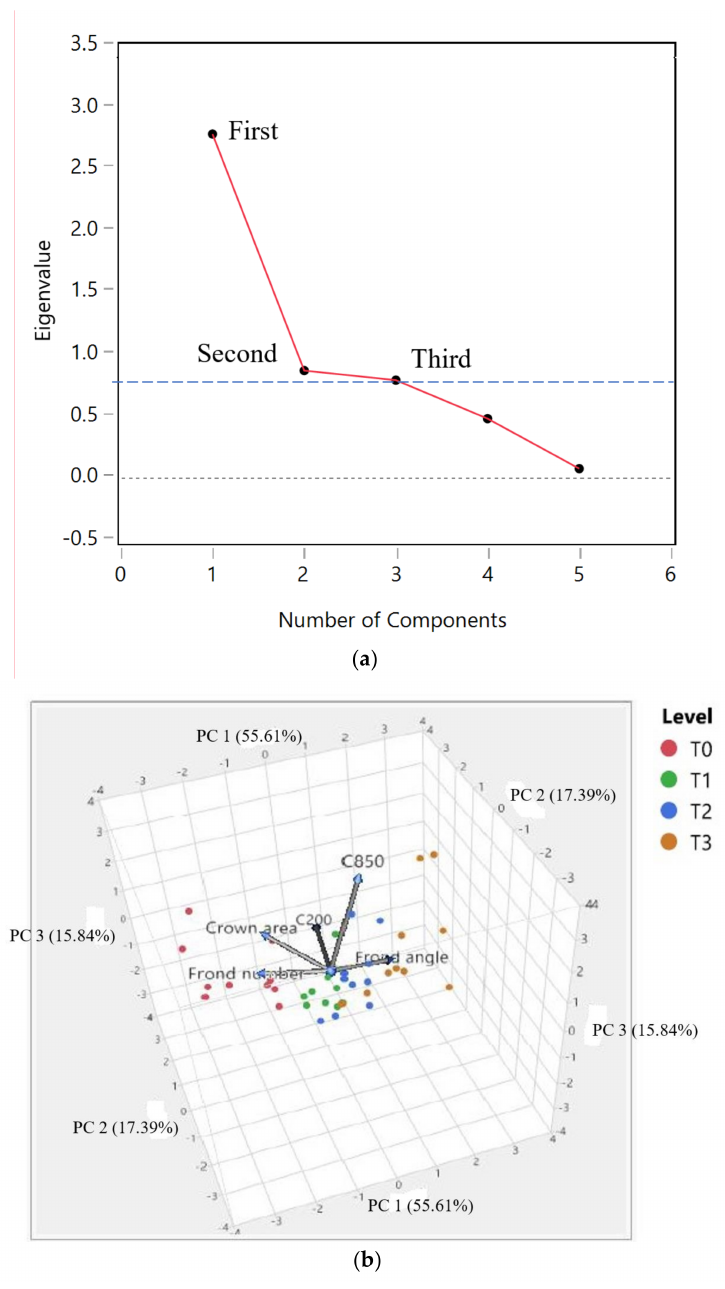
Figure 5. ( a ) Scree plot of the principal component analysis (PCA) eigenvalues and ( b ) principal component score 3D